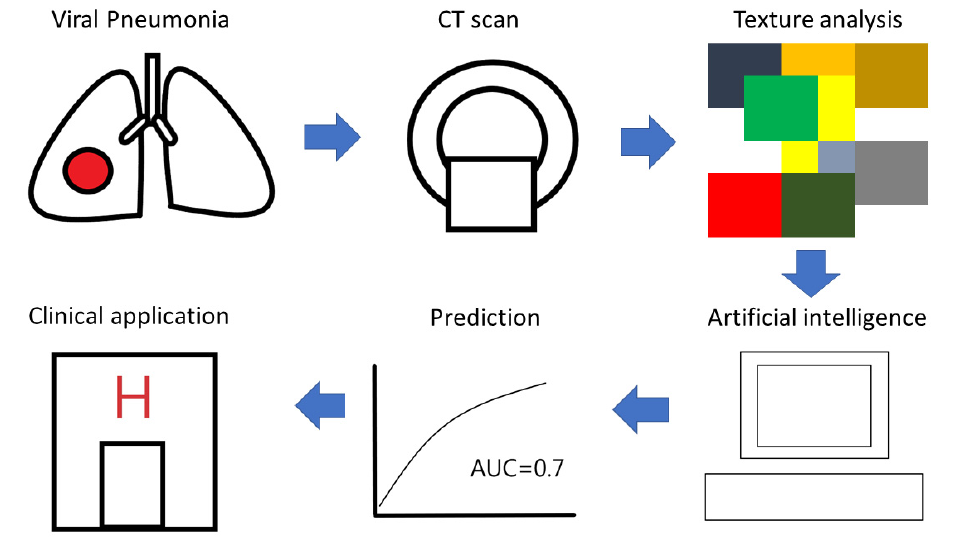
Figure 2. Workflow of the radiomics study.